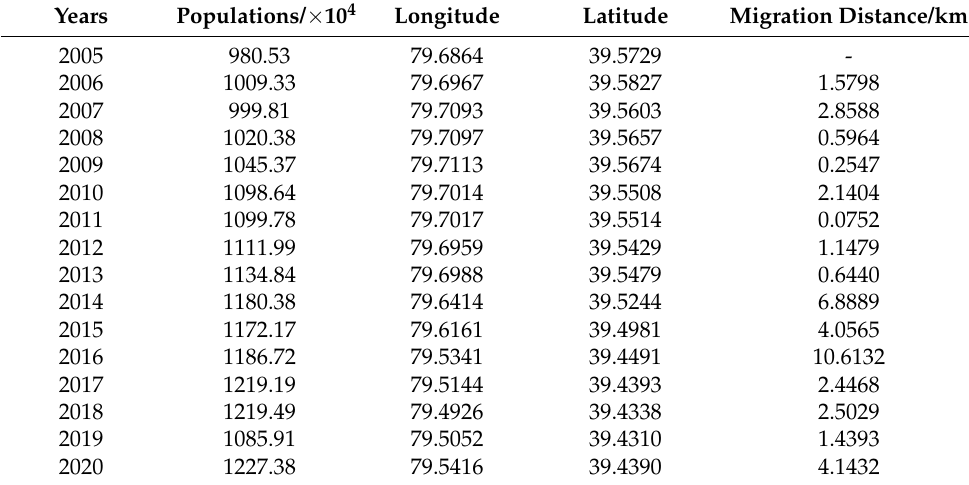
Table 3. The number of populations, center of gravity coordinates, and migration distance in the Tarim River